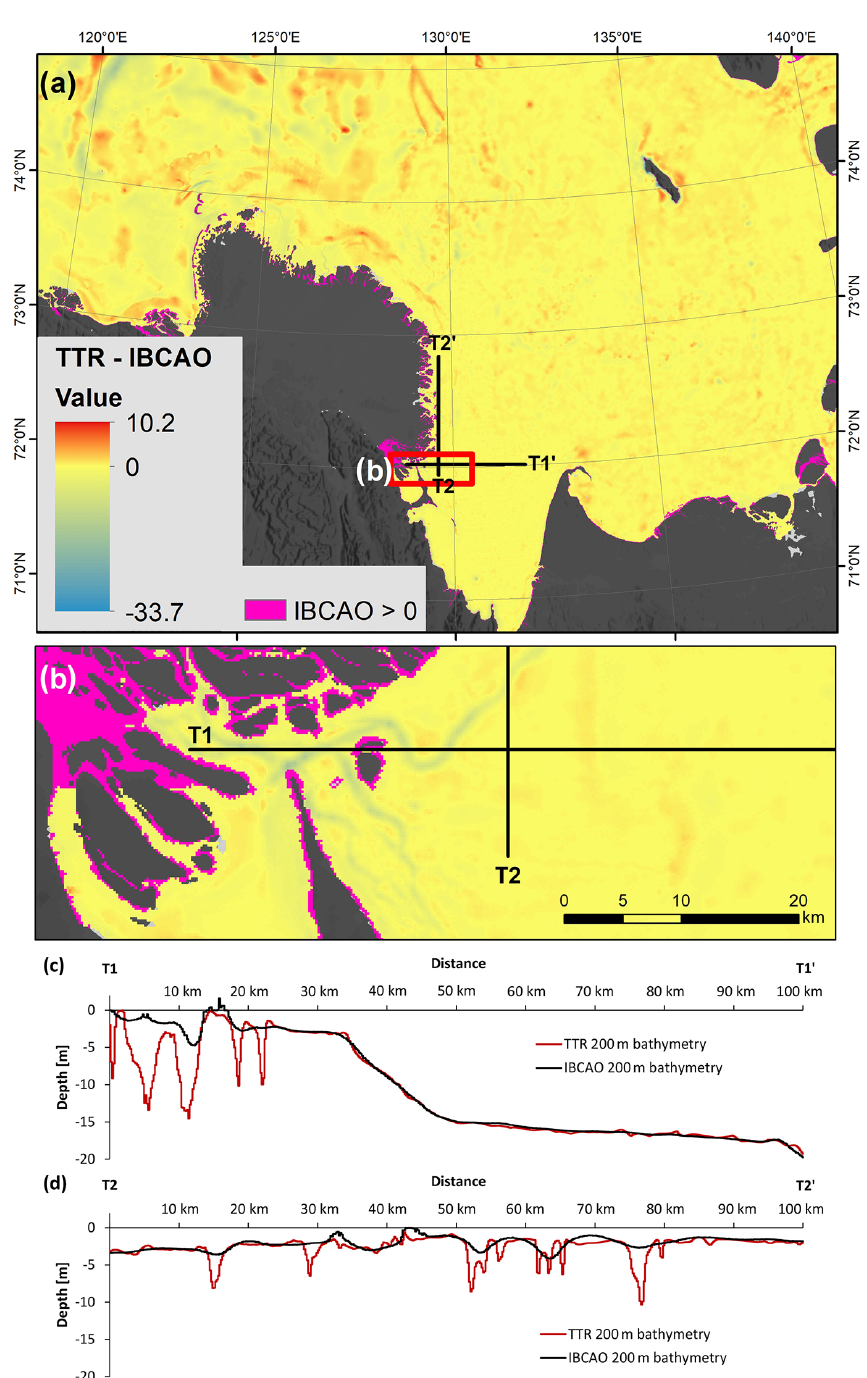
Figure 8. Depth difference map for the TTR 200 bathymetrical model and the IBCAO v4 200m bathymetrical data set in the Lena Delta region (TTR 200 minus IBCAO v4). Purple zones show areas where the IBCAO v4 incorrectly provides values above sea level. Reddish areas depict zones where the IBCAO v4 overestimates the depth in comparison to the TTR 200 . Blueish areas show zones where the IBCAO v4 has lower water depths than the TTR 200 . The highest positive value (10.2m, red) means that the IBCAO v4 indicates a depth which is 10.2m deeper than in the TTR 200 . Panels (c) and (d) show cross-sections deriving depth data from both data sets (TTR 200 in red and IBCAO v4 in black) in the near-shore zone, indicating the higher spatial variability and detection of deep river channels in the TTR 200 .